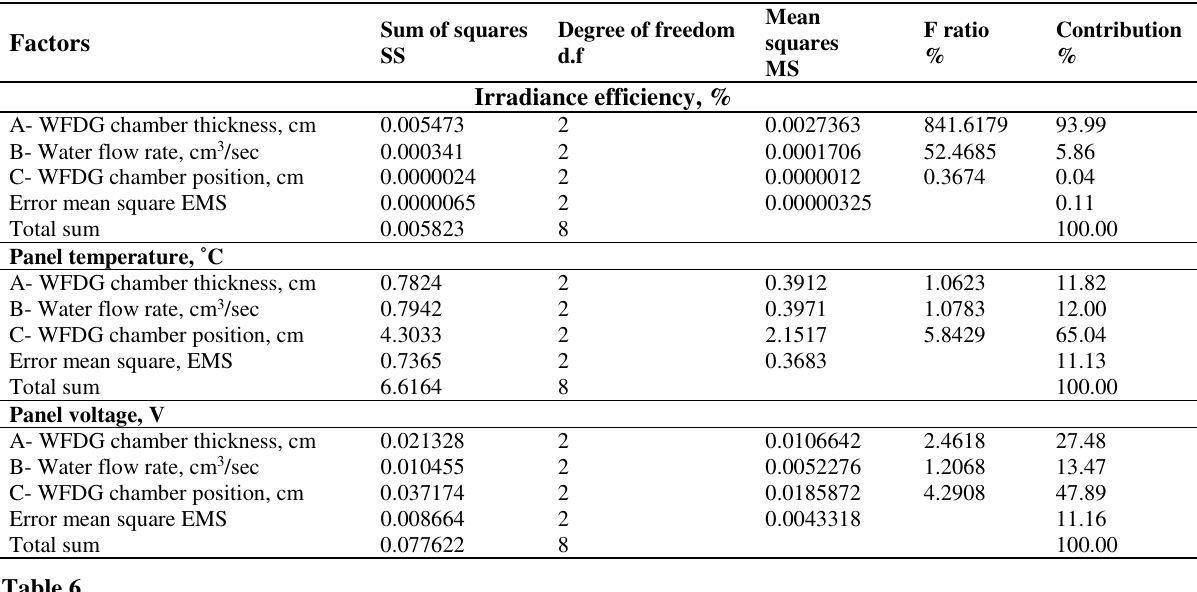
Results of ANOVA .